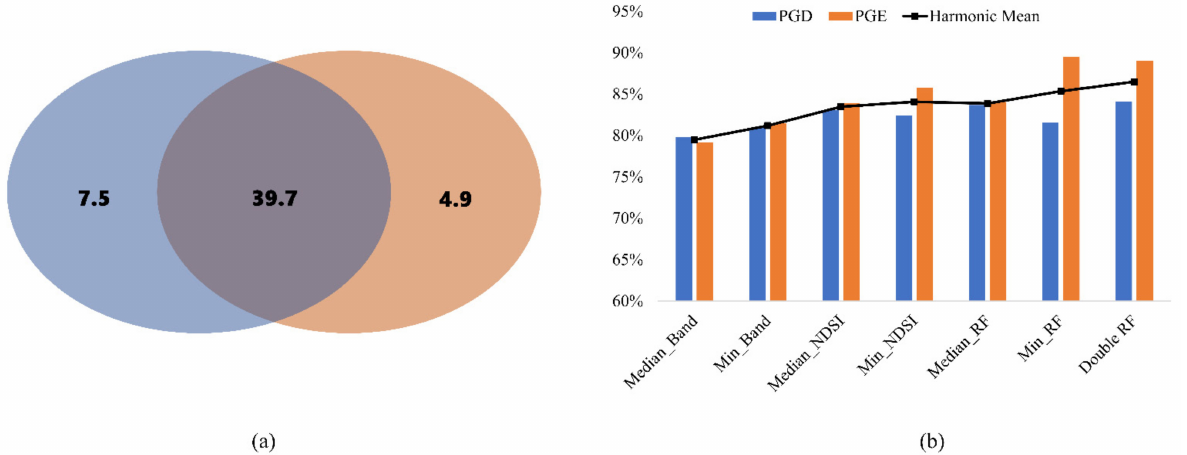
Figure 11. Comparison of extraction results of different methods. ( a ) Comparison between the results obtained by the Double RF method and the glacier dataset. The blue part represents the glaciers in the dataset, the yellow part represents the extracted glaciers, and the intersecting part represents the correctly extracted glaciers. The numbers above each part represent the area of the glacier in that part, and the unit is 1000 square kilometers. ( b ) shows PGD, PGE. and HM for the seven